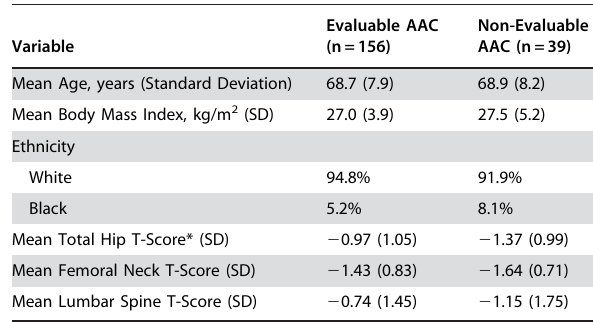
Table 1. Baseline characteristics of study population. ... ... ... .... ... ... .... ... ... .... ... ... .... ... ... .... ... ... .... ... ... .